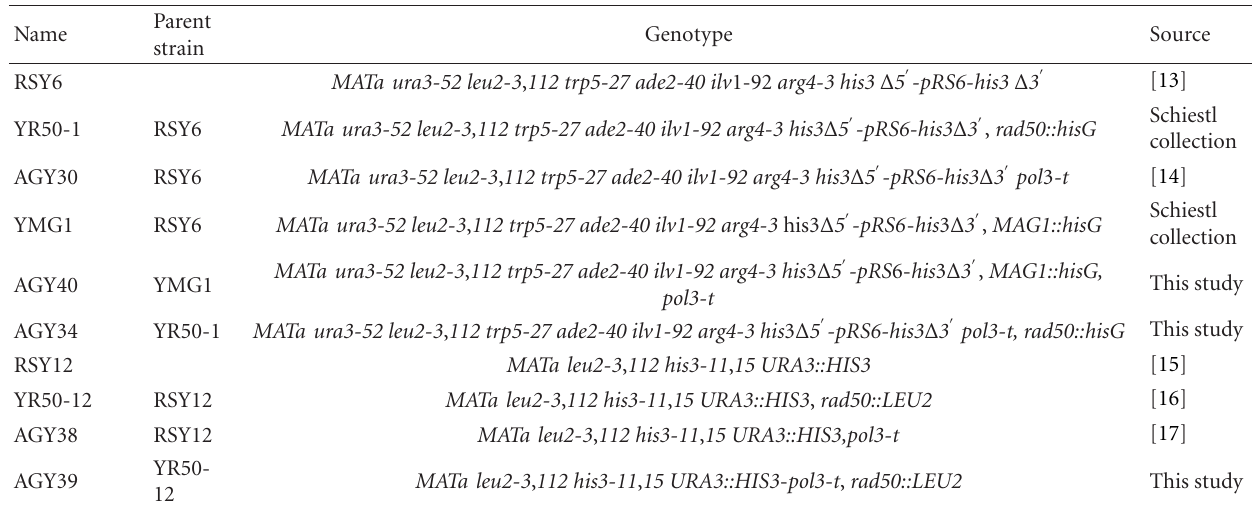
Table 1: Saccharomyces cerevisiae